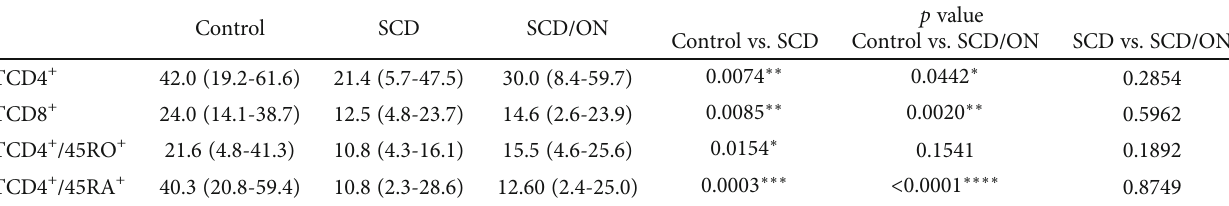
Table 3: Lymphocyte frequencies (%) in